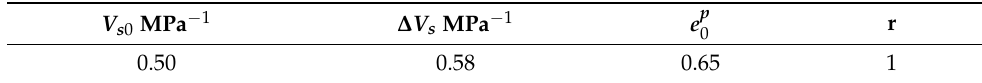
Table 2. Stress drop